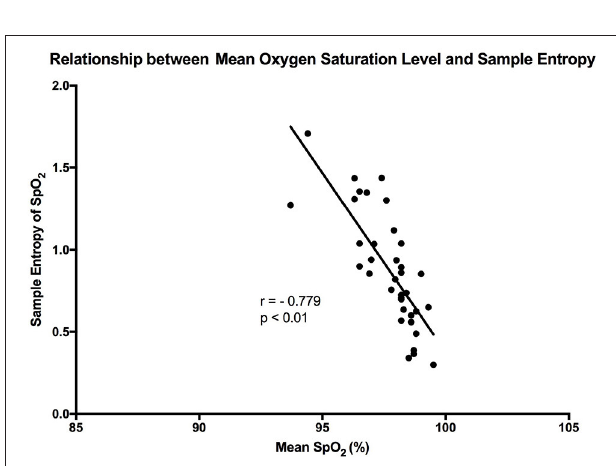
FIGURE 4 | An example of DFA Analysis on SpO 2 variability data showing the linear trend when plotting (n) and F (n) on a log-log scale. The arrow indicates the approximate point of the cross-over phenomenon.